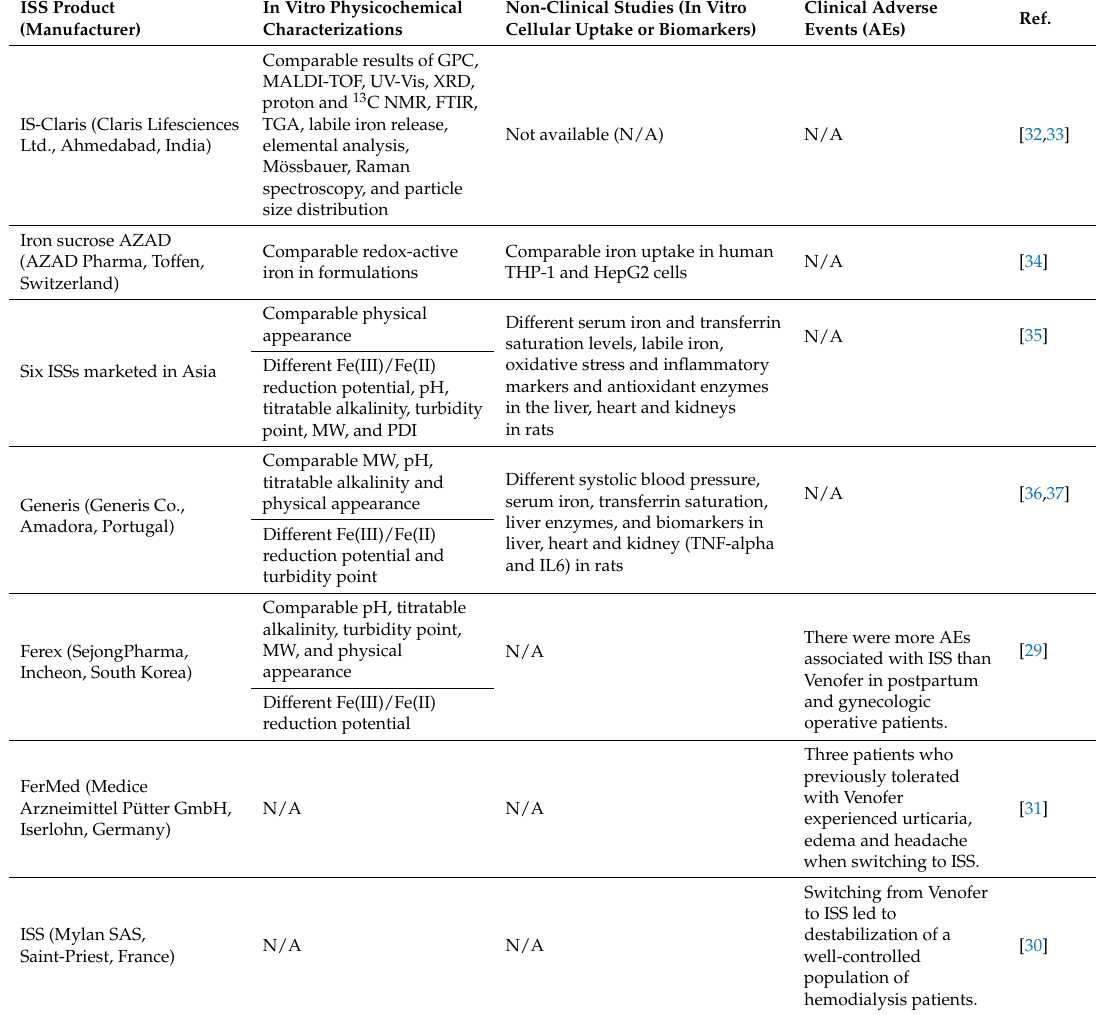
Table 8. Comparative in vitro physicochemical characterizations, non-clinical studies and clinical adverse events between Venofer (iron sucrose) and various Iron Sucrose Similar (ISS) products in the